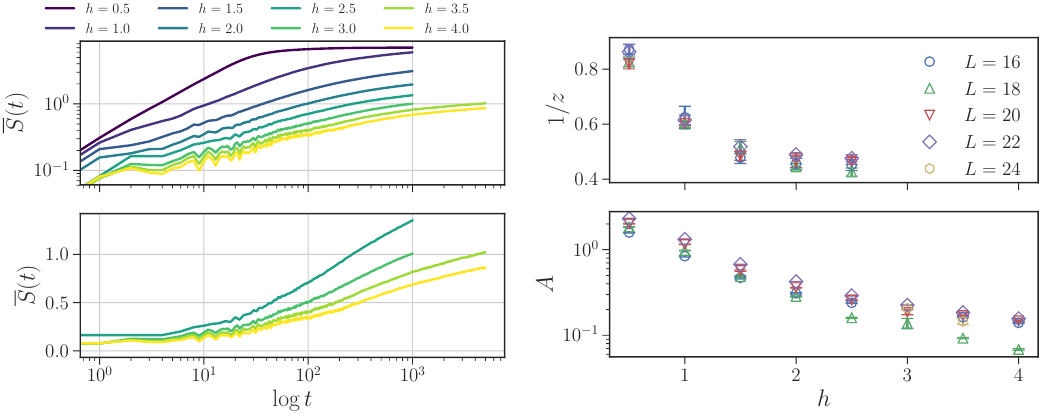
Figure 12: Left: Entanglement as a function of time, in log-log scale (upper panel) and in log-linear scale (lower panel), for the chain of L = 22 sites. Right: Best fits of the form S ( t ) ∝ t 1 / z (upper panel) and S ( t ) = A log t (lower panel).